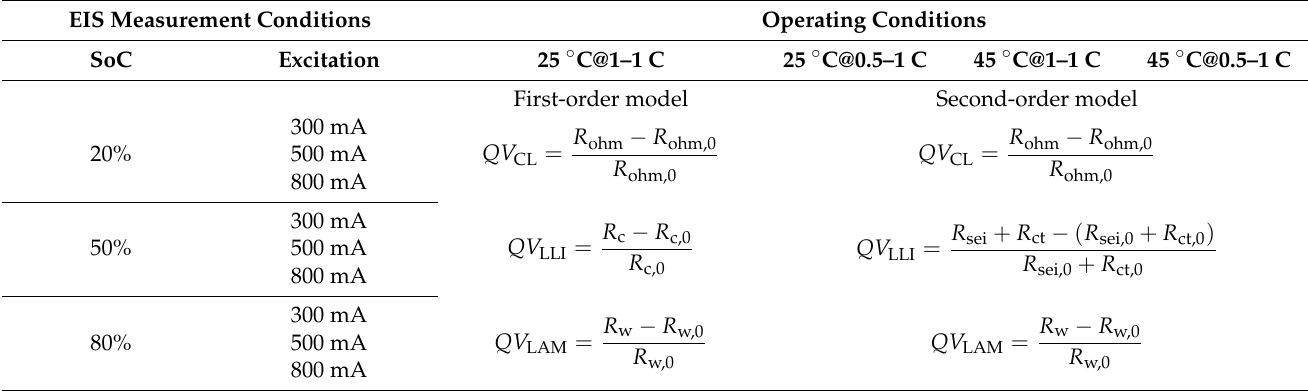
Table 3. Quantification schemes under different EIS measurement conditions and operating conditions. EIS Measurement